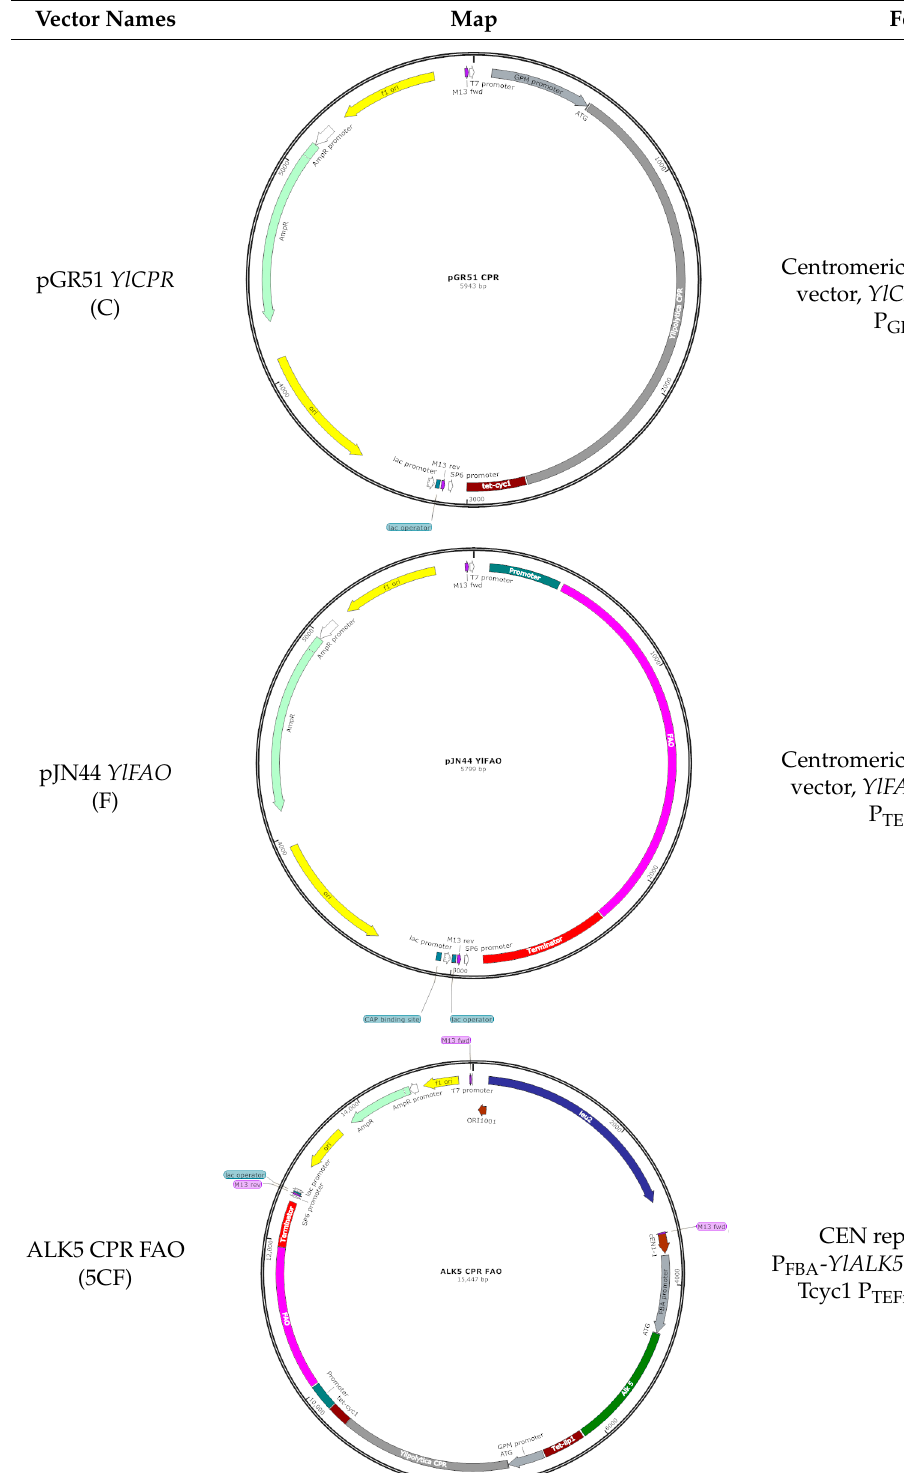
Table 2. Vectors used in this